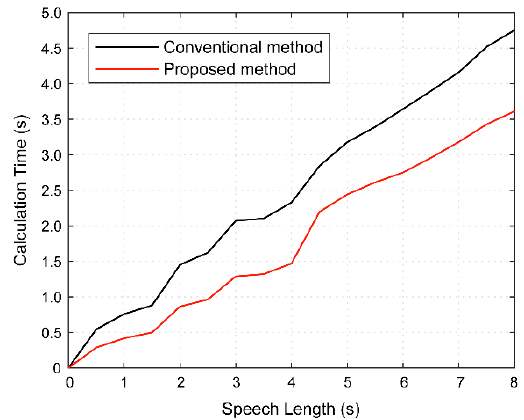
Figure 7. Calculation time according to speech length of reference and proposed calculation methods.